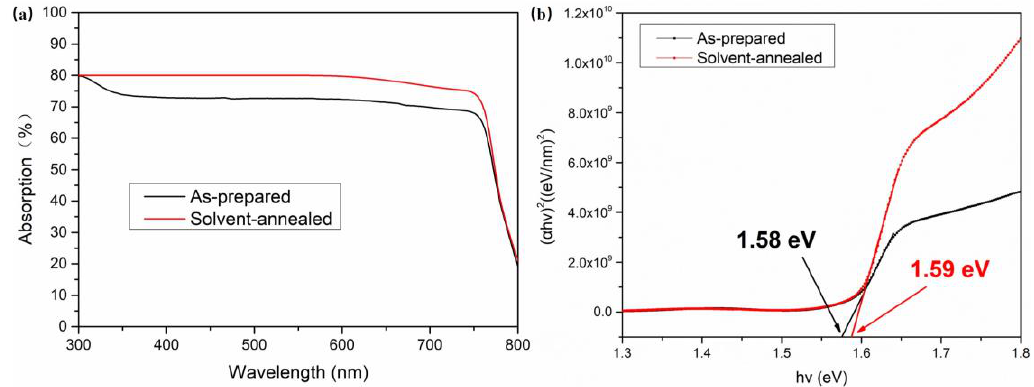
Figure 5. ( a ) Optical absorption spectra and ( b ) the corresponding Tauc plots of the as-prepared and solvent-annealed CH 3 NH 3 PbI 3 films.